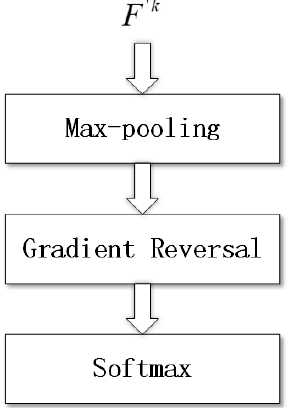
Figure 3. Ordinary adversarial discriminator.